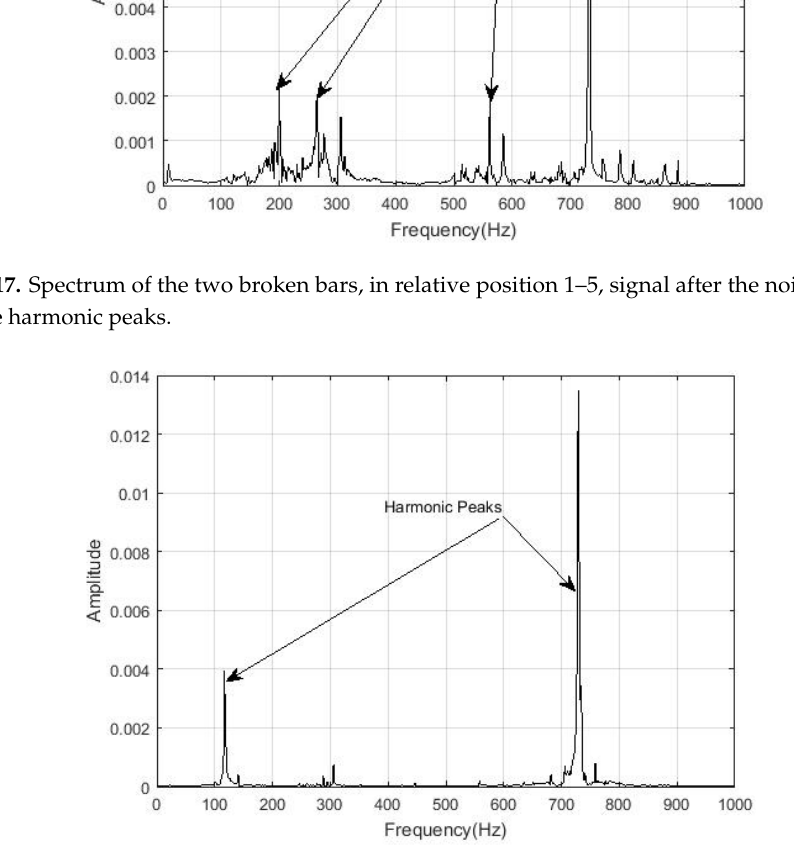
Figure 18. Spectrum of the two broken bars, in relative position 1–3, signal after the noise reduction with the harmonic peaks.